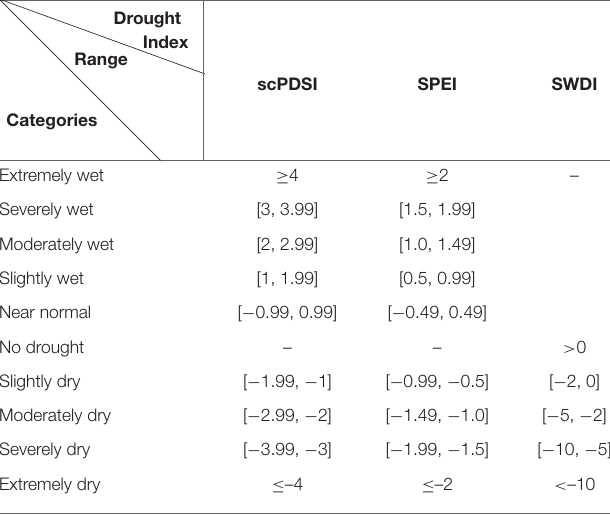
TABLE 1 | Drought index classification for the scPDSI (Wells et al., 2004), SPEI (Vicente-Serrano et al., 2010), and SWDI (Martínez-Fernández et al., 2016). Drought